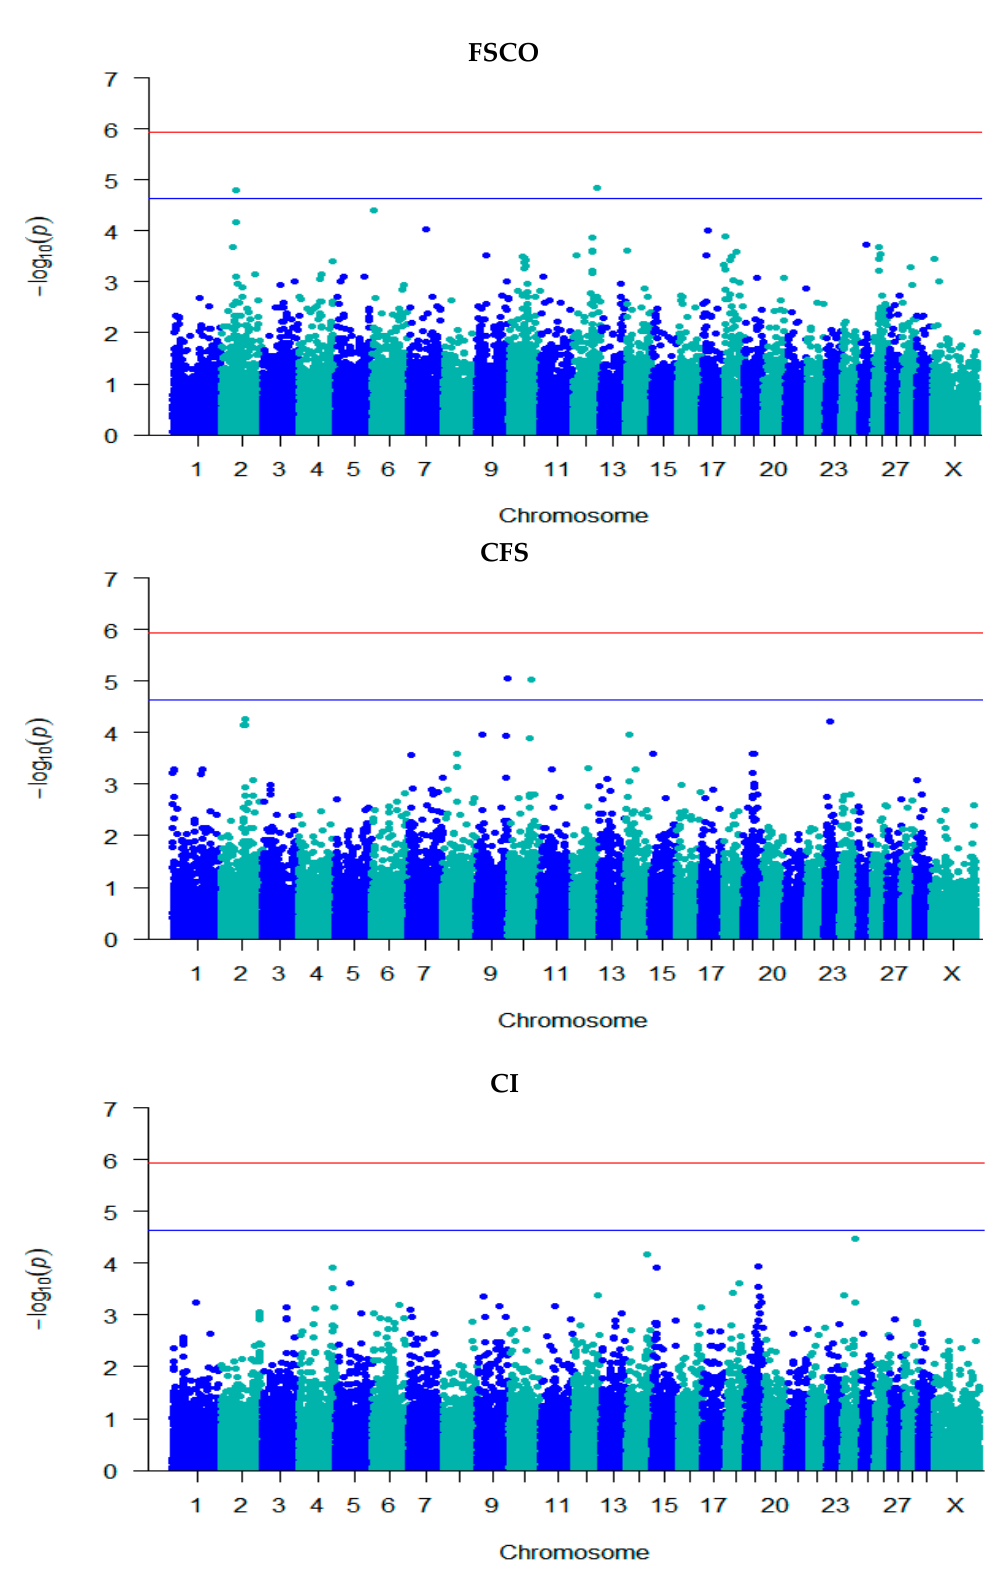
SR21 Figure 2. Cont